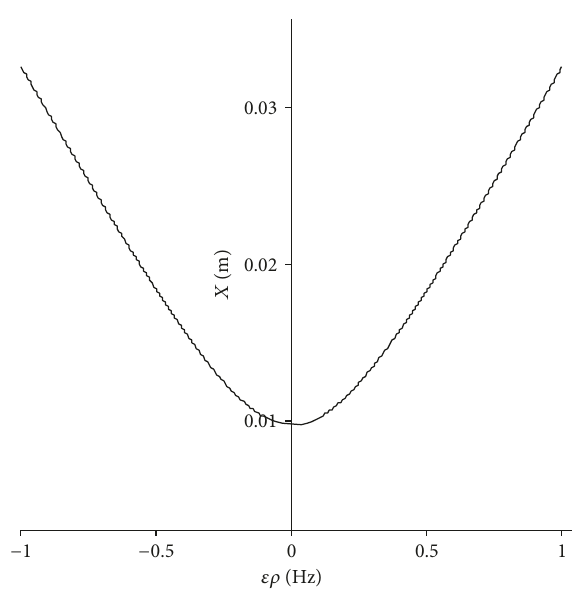
Figure 4: Frequency response of the primary system.